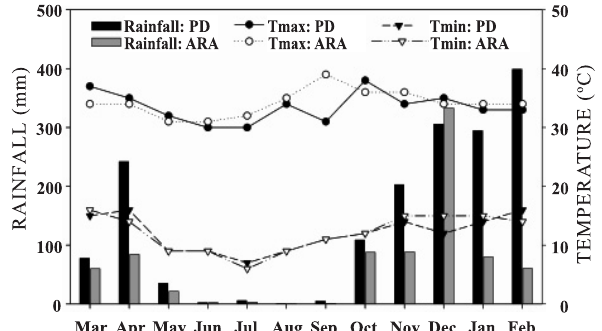
Figure 1. Monthly rainfall and maximum (Tmax) and minimum (Tmin) temperature on the studied farms in PD (Pedra Dourada) and ARA